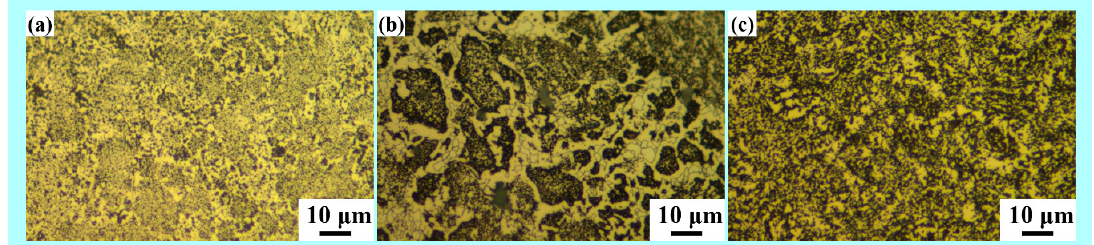
Figure 5. Optical microscopy images showing the microstructures of the samples ( a ) alloy A, ( b ) alloy B, and ( c ) alloy C after vacuum hot pressing.